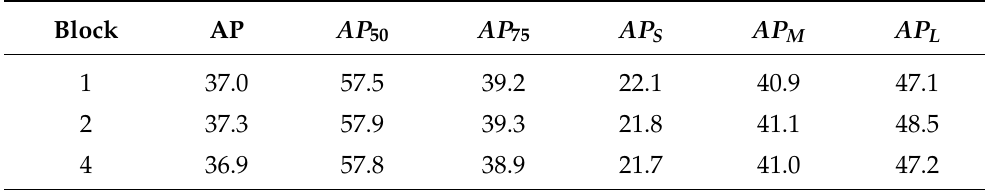
Table 3. Ablation studies of block number on COCO